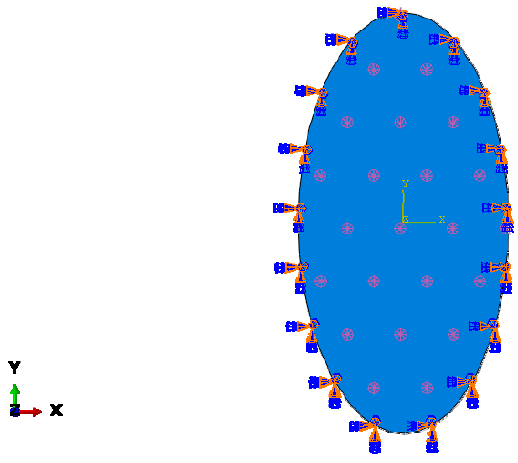
Figure 4. Boundary conditions and loads in the finite element model.